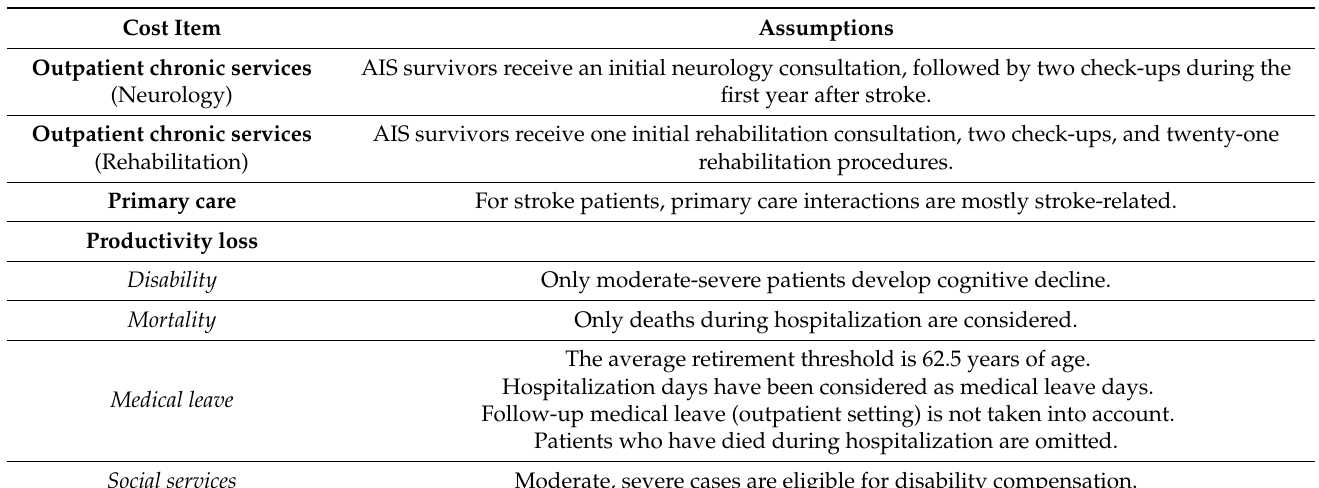
Table 1. Assumptions made when estimating